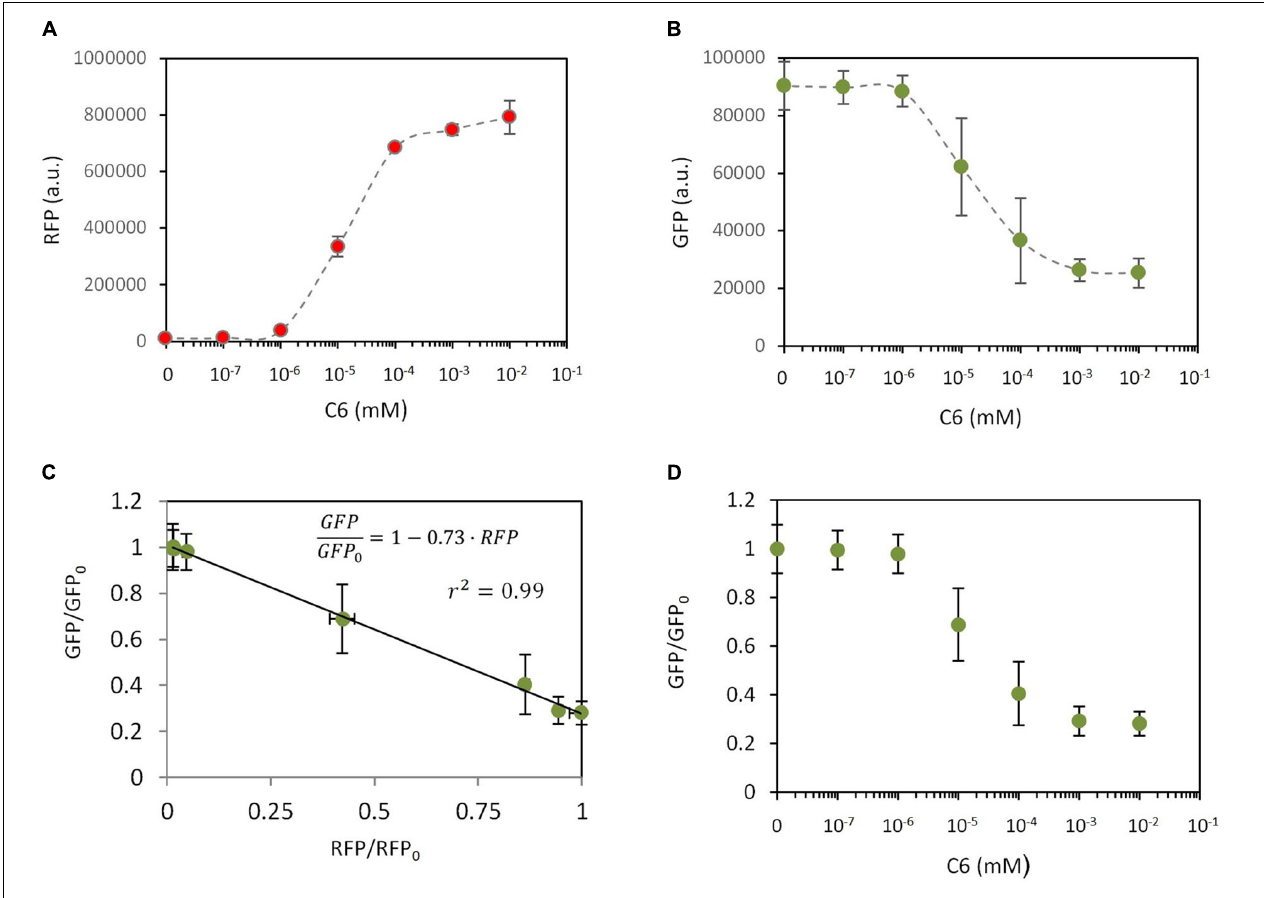
FIGURE 3 | Dependencies of gene expression in response to an external inducer. In all experiments, a construct (C17) from which GFP is constitutively expressed and RFP expression can be induced by C6 addition, was used. RFP levels (A) and GFP levels (B) were measured (a.u., arbitrary units) in response to different C6 concentrations. (C) Correlation between GFP fold change and RFP fold change. Dots are experimental values and the solid line is the model fitting. (D) Dependence of GFP fold change on the C6 concentration. Dots are experimental values and the solid line is the model fitting. This fitting combines the experimentally measured relationship between RFP and C6 with the relationship between GFP/GFP 0 and RFP described by equation